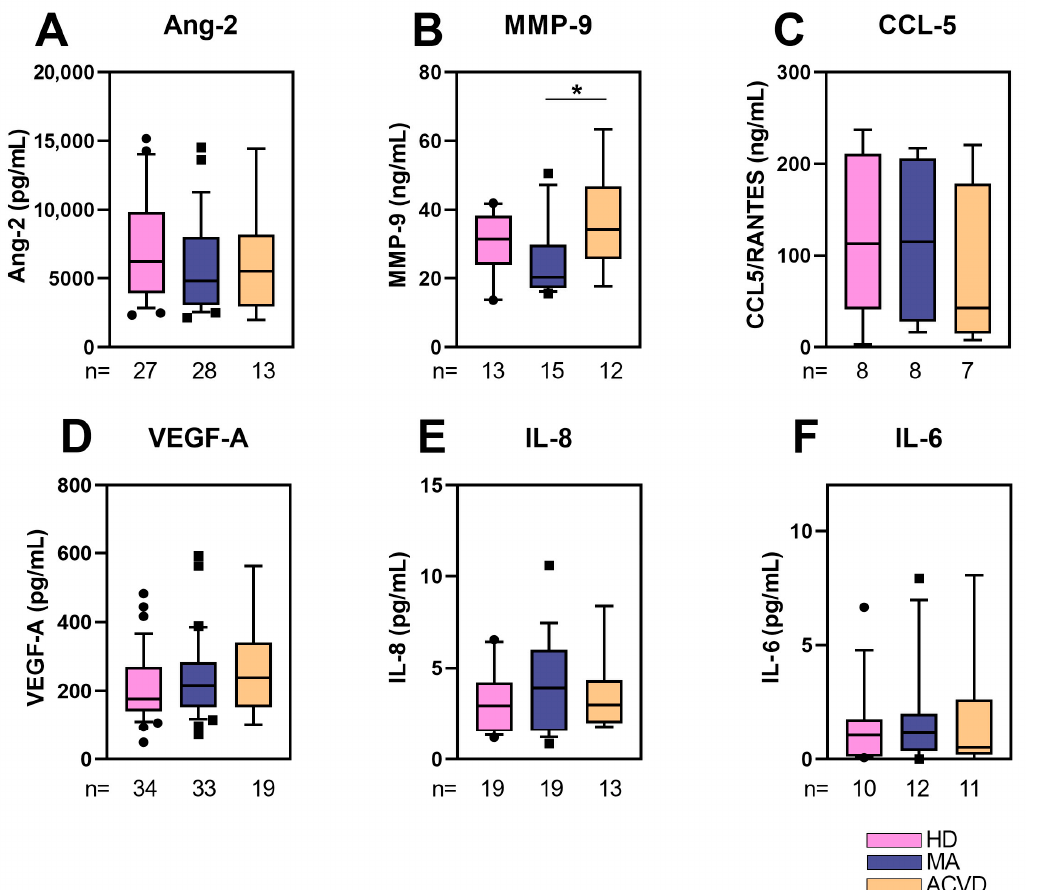
Figure 1. ( A ) Angiopoietin-2 (Ang-2), ( B ) matrix metalloprotease-9 (MMP-9), ( C ) chemokine (C-C motif) ligand 5 (CCL5/RANTES), ( D ) Vascular Endothelial Growth Factor-A (VEGF-A), ( E ) interleukin 8 (IL-8/CXCL8), and ( F ) interleukin 6 (IL-6) concentration (pg/mL for A , D , E , F or ng/mL for B , C ) in plasma collected from MA patients, HD and ACVD subjects. The boxes represent data obtained in the range 25th–75th percentile; the line across the boxes indicates the median value; the lines above and below the boxes indicate extreme values (10th or 90th percentile). The statistical significance (* p < 0.05) was calculated through Student’s t -test. Values of at least three independent experiments are shown.